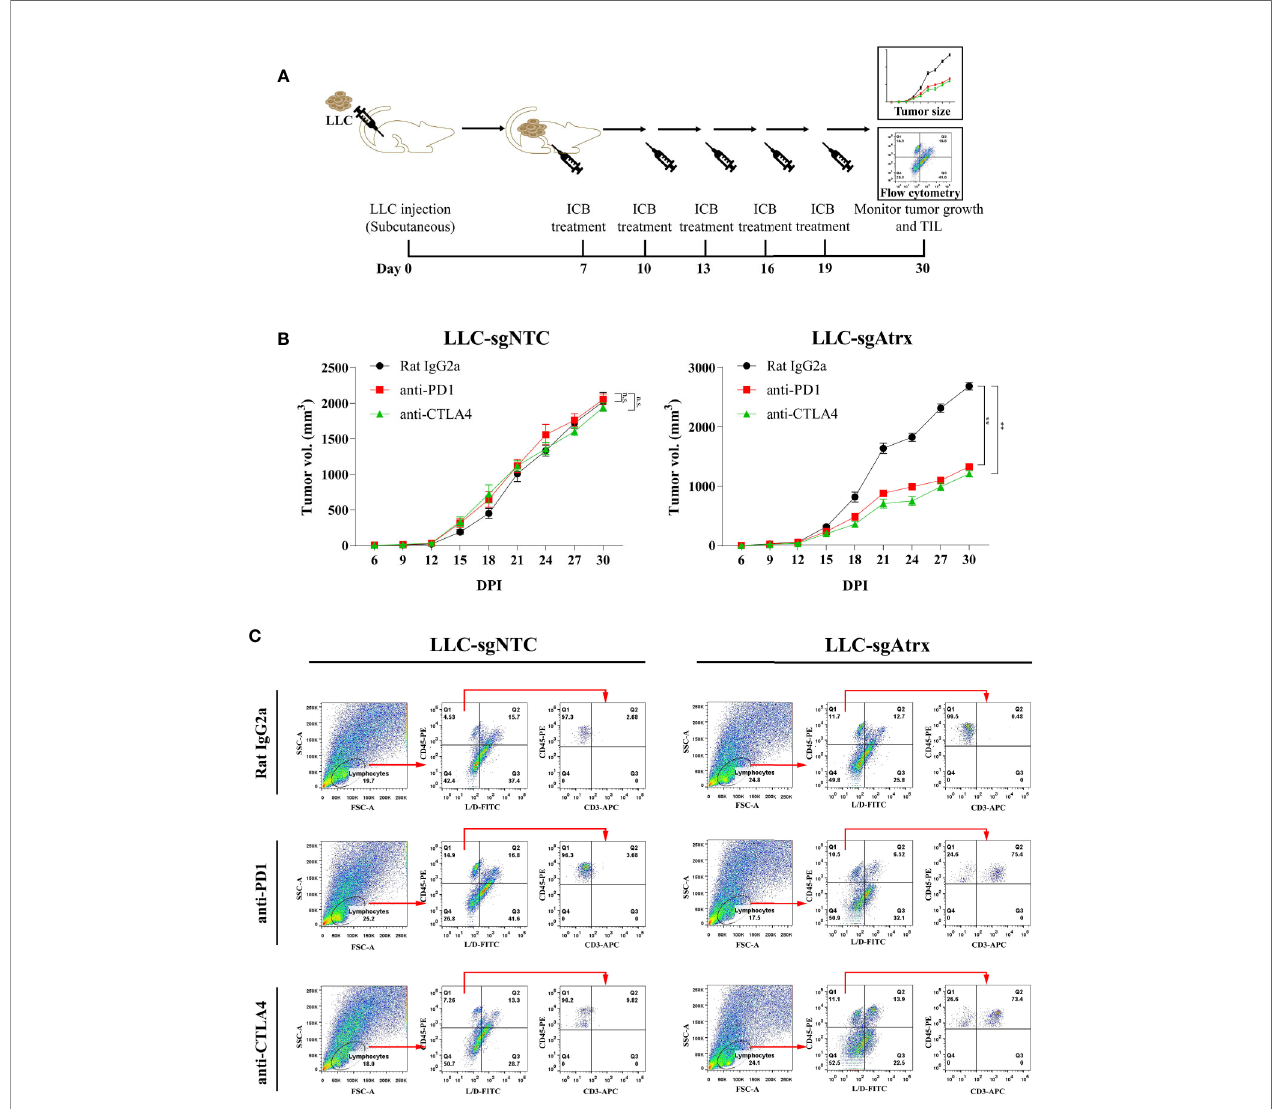
FIGURE 3 | Atrx de fi ciency sensitizes NSCLC to ICI treatment in subcutaneous syngeneic mouse model. (A) Experimental design for subcutaneous tumor model establishment and analysis of tumor-in fi ltrating immune cells. (B) Tumor volume curves of mice bearing LLC tumors with and without Atrx knockout. Neither aCTLA4 (n = 5) nor aPD1 (n = 5) treated mice showed a signi fi cant volume difference in Atrx-expression mice, compared with control group (n = 5) ( P = 0.8712, 0.8981). Both aCTLA4 (n = 5) and aPD1 (n = 5) treated mice showed a signi fi cant volume difference in Atrx-de fi cient mice, compared with control group (n = 5) ( P = 0.005, 0.008). (C) T cell proportion in the microenvironment of LLC generated tumors with and without Atrx de fi ciency after ICI or isotype antibody treatment. Quanti fi cation of CD45+ immune cells in tumor sections from Atrx expression, or Atrx-de fi cient tumors, with or without anti-PD1, anti-CTLA4 treatment. Two-tailed unpaired